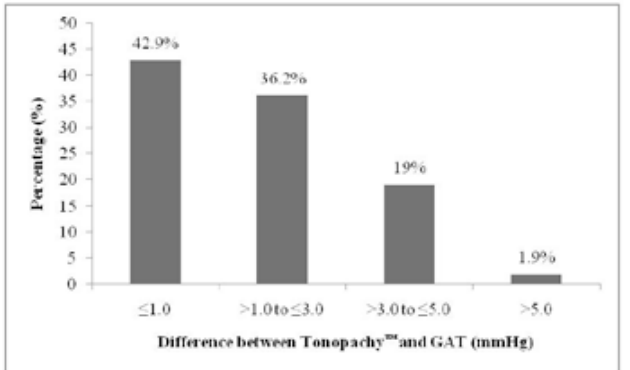
Figure 4: Frequency distribution of the difference between Tonopachy™ and GAT measurements.